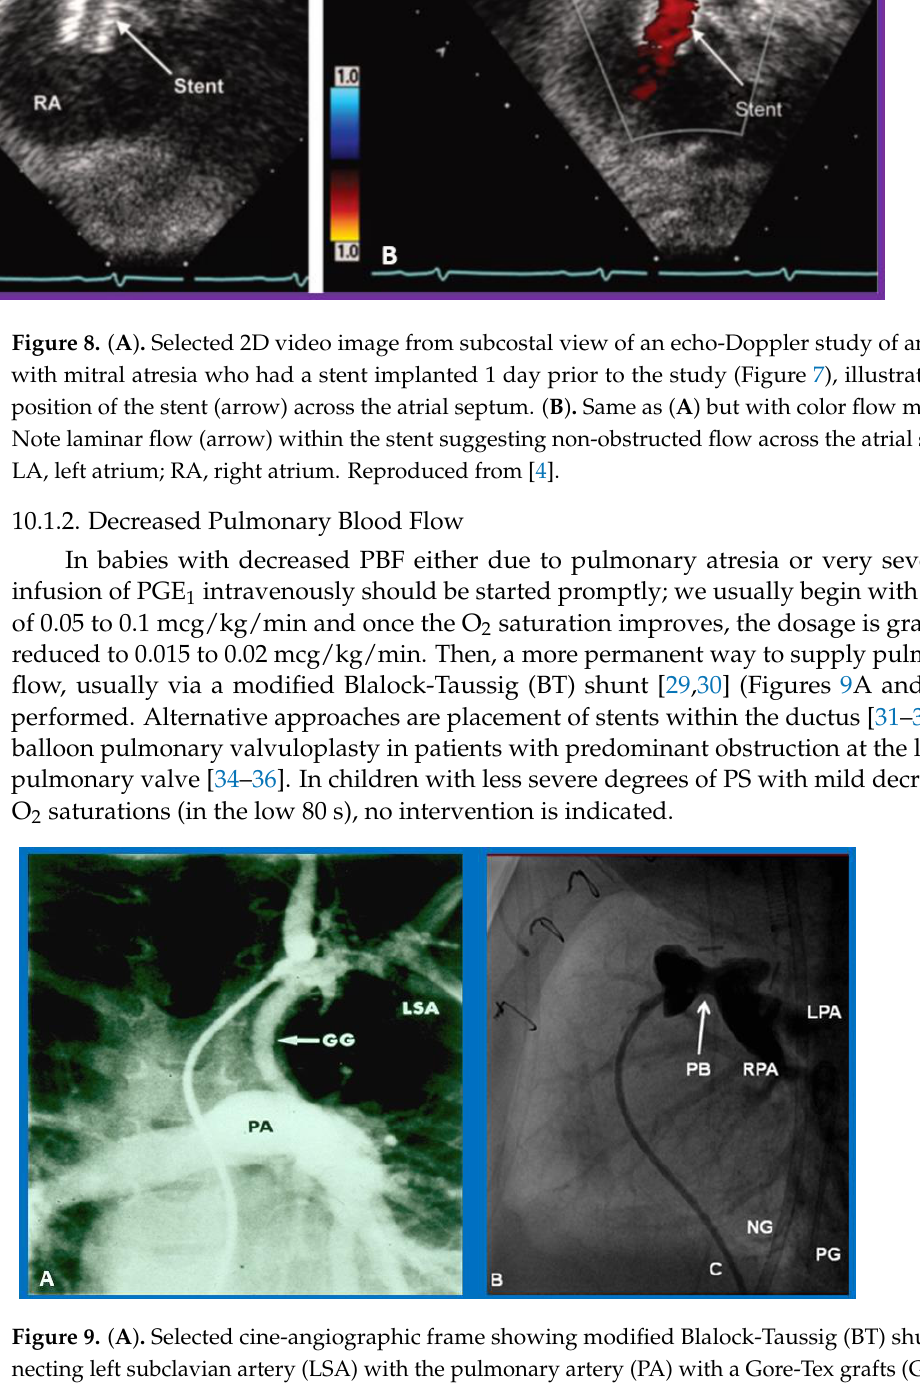
Figure 7. ( A ) to ( D ) : Selected cine frames while implanting the stent across a severely restrictive patent foramen ovale shown in Figure 5, illustrating the position of the stent prior to balloon infla- tion ( A ), during balloon inflation with a waist (W) of the balloon ( B ), and at the conclusion ( C ) of stent implantation. The position of the fully inflated stent (FI) before ( C ) and following ( D ) removal of the balloon is shown. Sternal wires from prior surgery are seen, but not labeled. PT, marker pigtail catheter. Modified from [4].